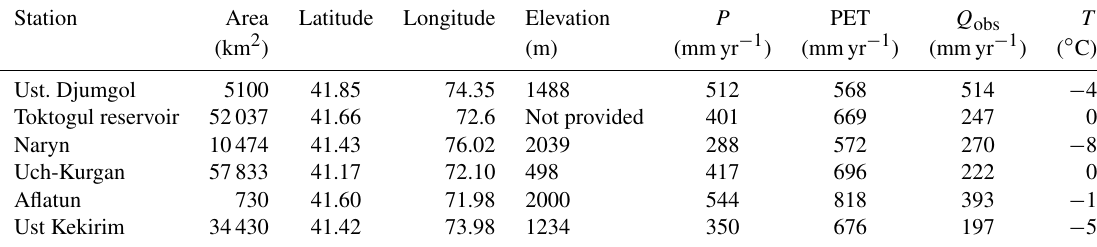
Table 2. The location, catchment area and elevation of the gauging stations from the Global Runoff Data Centre. Also listed are the annual mean climatologies (1951–1970) for APHRODITE precipitation ( P ), ERA5 potential evapotranspiration (PET), ERA5 air temperature ( T ) and observed discharge ( Q obs